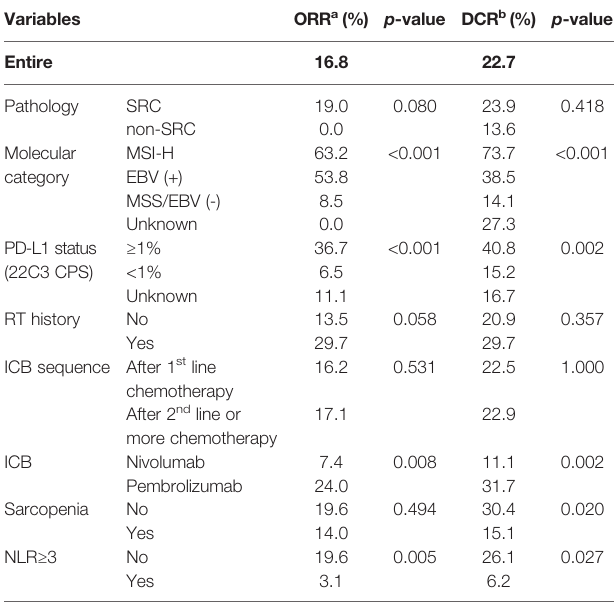
TABLE 2 | Response rate of immune checkpoint blockade.